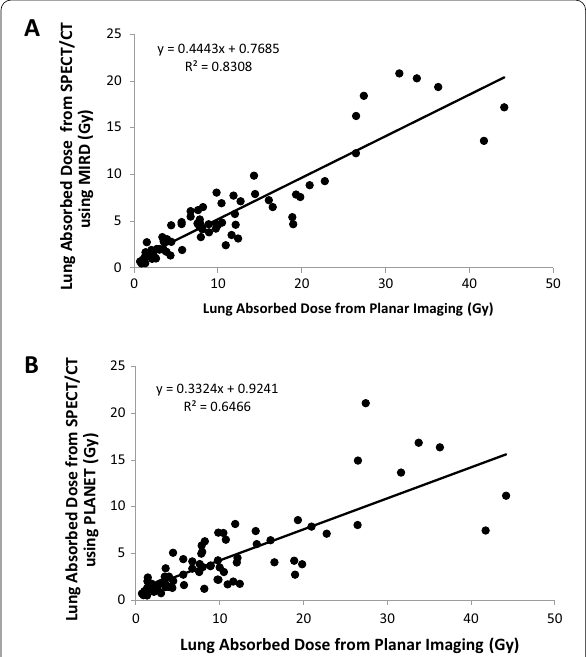
Fig. 4 A Linear correlation of lung absorbed dose from planar imaging vs. SPECT/CT (MIRD formulation). B Linear correlation of lung absorbed dose from planar imaging vs. SPECT/CT (PLANET software)